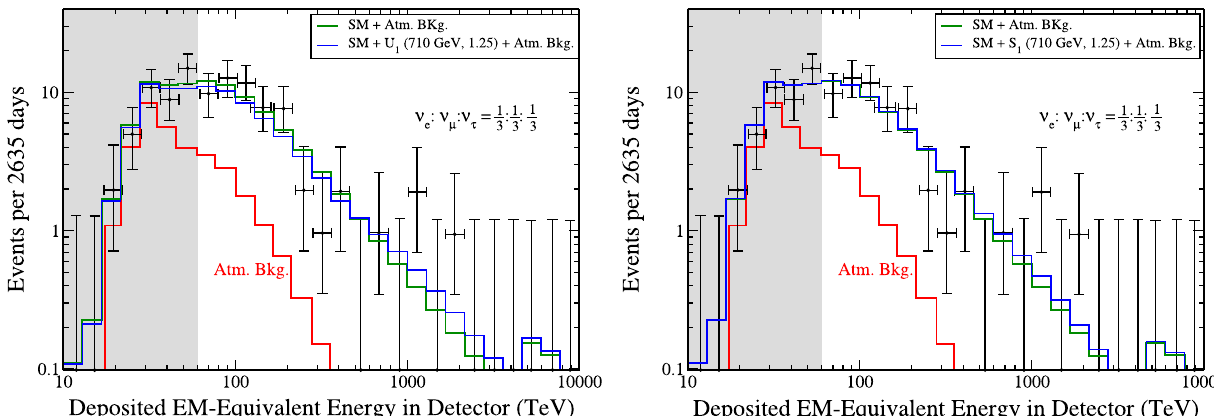
= 710GeV( χ L = 1 . 25, χ L ,χ L = 0)(leftpanel),and m de d μ d τ 1